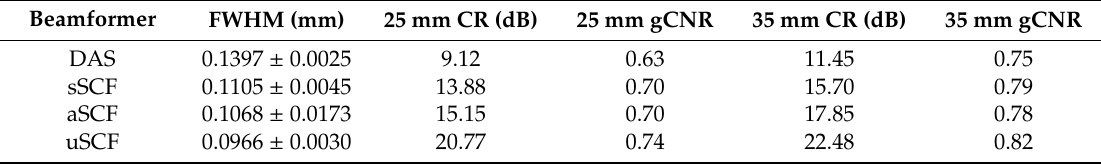
Table 2. Contrast performance from simulation.